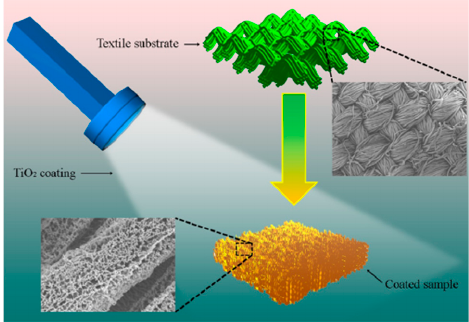
Figure 4. Scheme of the coating process. (Reprinted from Reference [84] with permission).